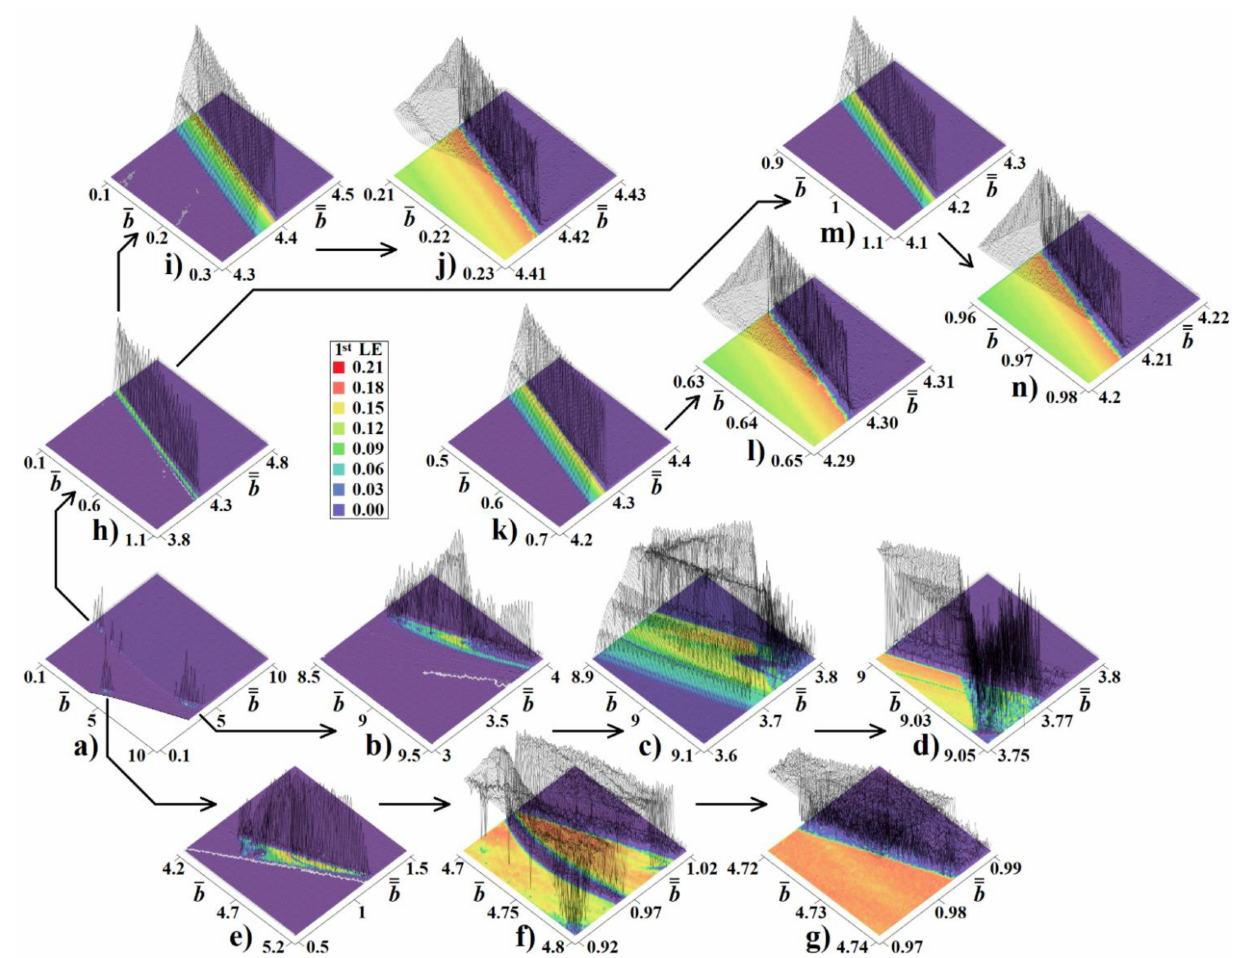
Figure 6. Cascoded resonant amplifier, fourth order system. Rainbow-scaled surface-contour plot of the largest LE, parameter step varies such that each plot contains equally spaced grid of 101 101 = 10,201 points. Zooming procedure: ( a )-( b )-( c )-( d ), ( a )-( e )-( f )-( g ), ( a )-( h )-( m ), ( a )-( h )-( i )-( j ).